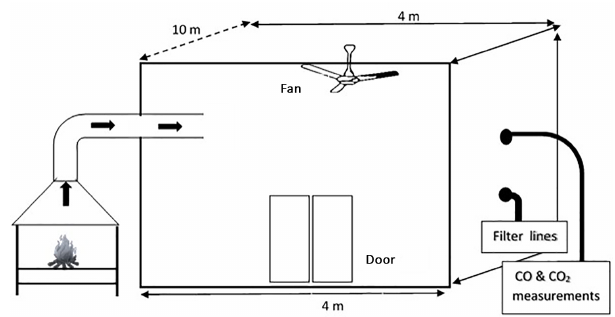
Figure 2. Schematic view of the Lannemezan combustion chamber.